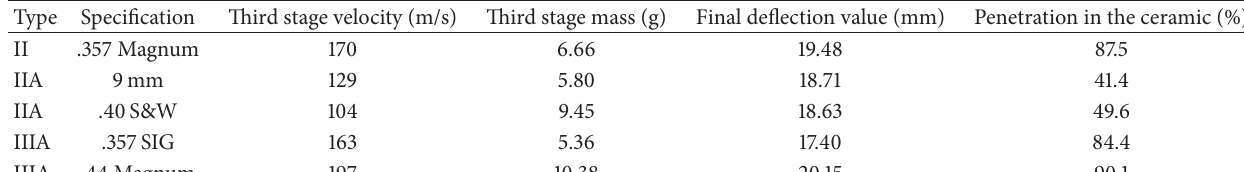
Table 8: Results of the simulation for several different calibers.